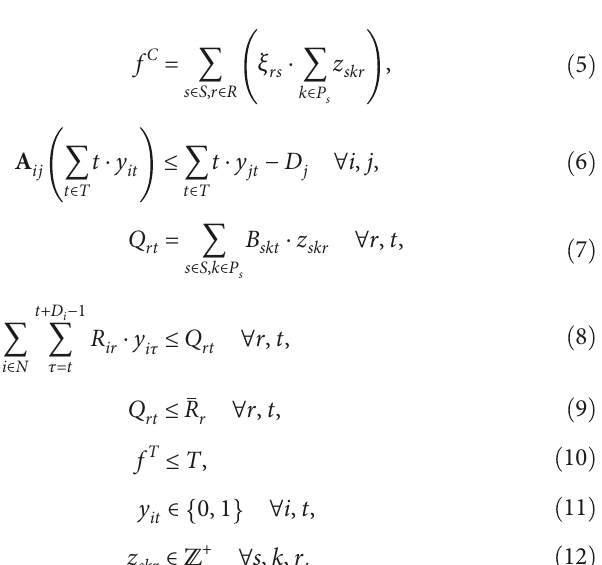
Figure 2: Intervals of multiple time